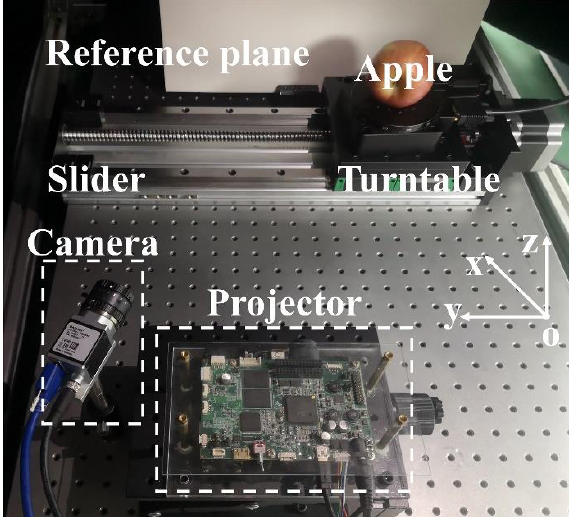
Figure 1. Schematic illustration of fringe projection system.